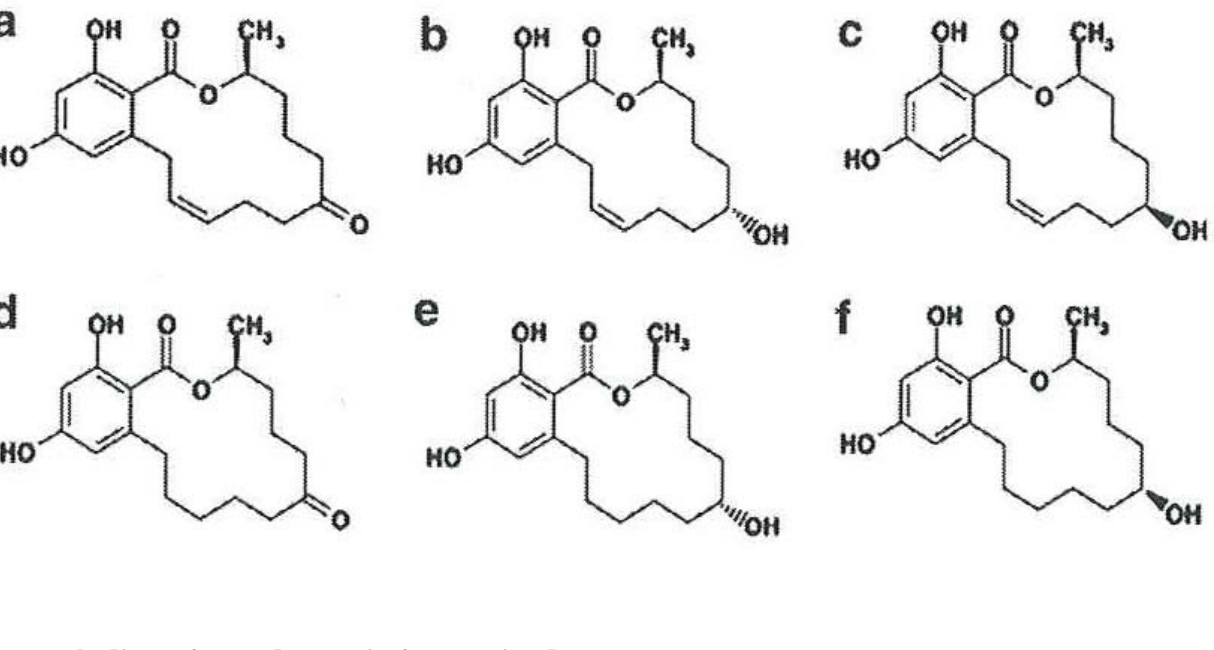
Figure 1. Chemical structures of zearalenone and its derivatives: a) zearalenone (ZEA), b) α -zearalenol ( α -ZOL), c) β -zearalenol ( β -ZOL), d) zearalanone (ZAN), e) α -zearalanol ( α - ZAL), f) β -zearalanol ( β -ZAL)